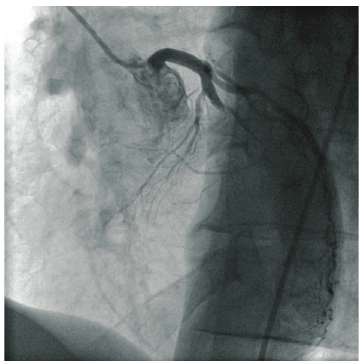
Figure 6: Occlusion of the left anterior descending coronary artery following intracoronary acethylcholine infusion (LAO 35, cranial 18) accompanied by ST-segment depression and T-wave